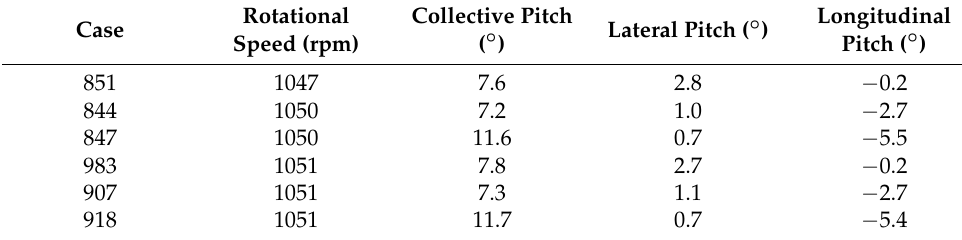
Table A4. BO105 rotational speed and control